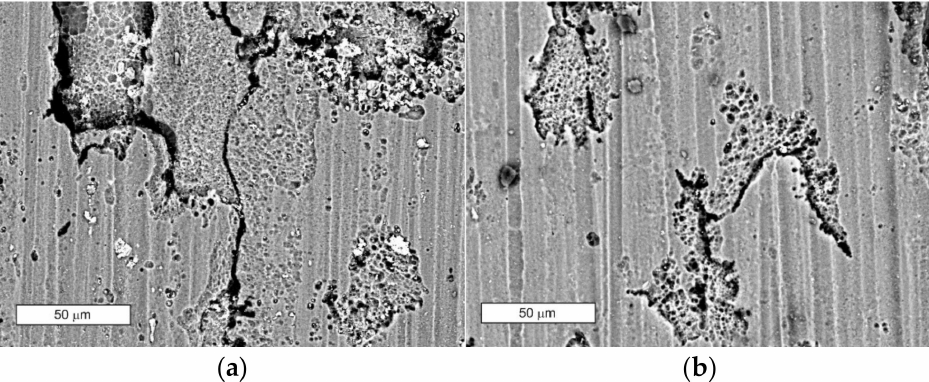
Figure 14. Corrosion initiated in the area of the grain boundary and propagating to the matrix in the DA state ( a , b ), SEM.